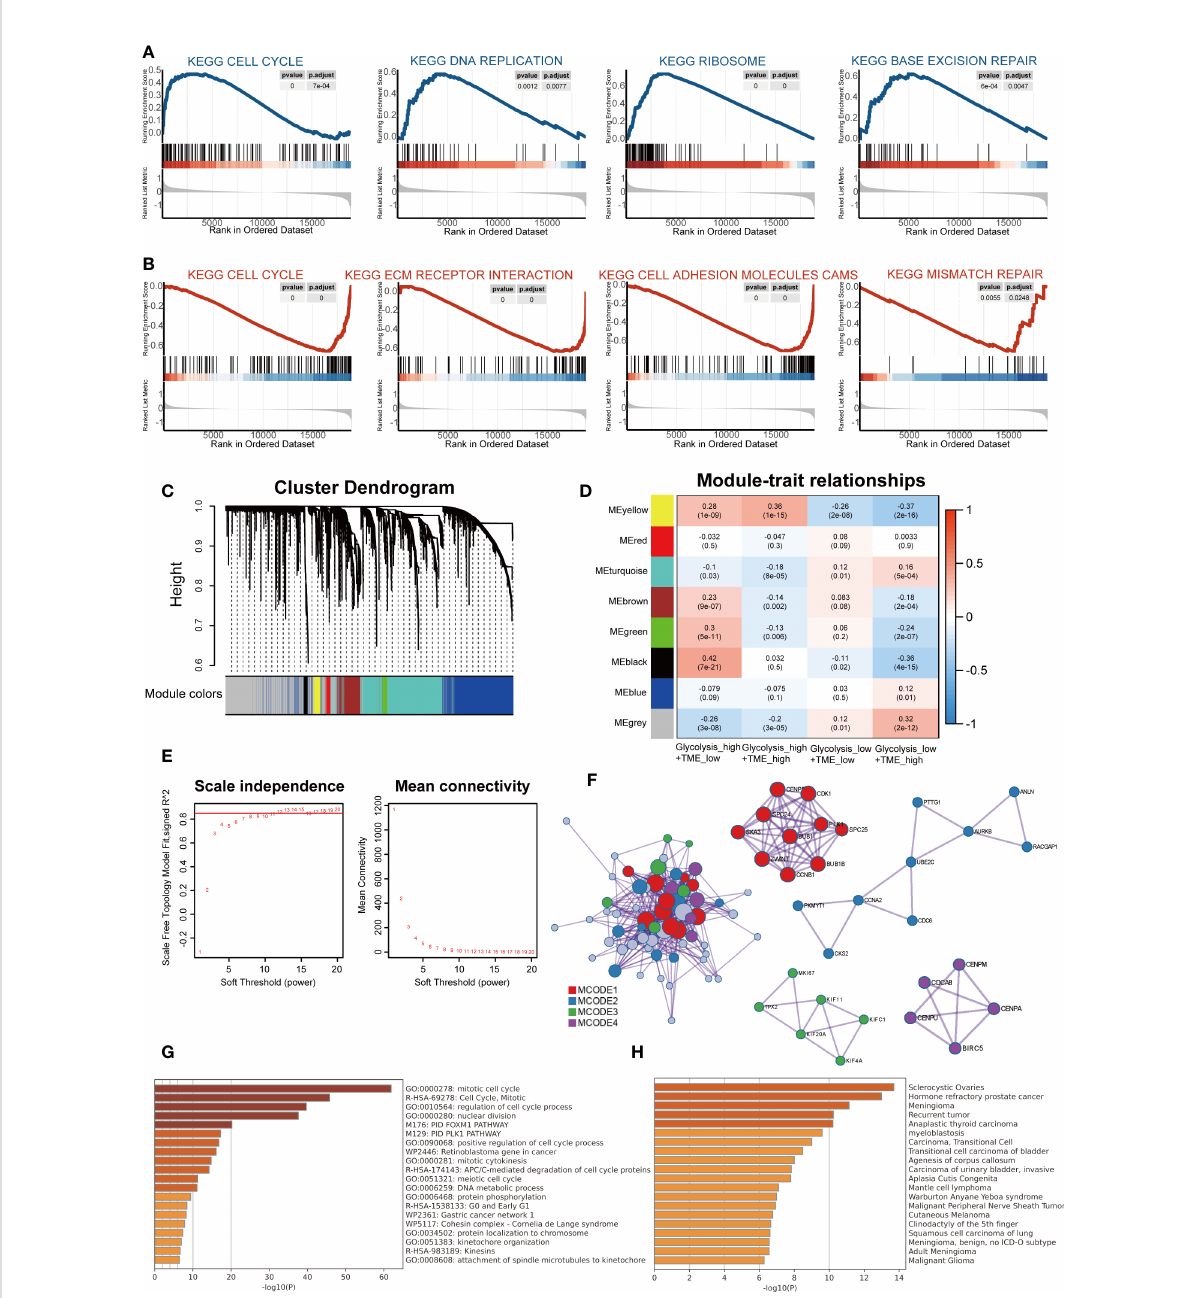
FIGURE 4 The distinct molecular functions and mechanisms among different groups. (A) Gene set enrichment analysis (GSEA) between groups with high- and low-glycolysis scores. (B) GSEA between groups with high- and low-TME scores. (C) Cluster Dendrogram. (D) Module-trait relationships. (E) Analysis of the network topology for various soft-thresholding powers. (F) Protein-protein interaction (PPI) network and four MCODEs identi fi ed in genes of the black module. (G) Potentially enriched terms for the gene list. (H) Bar graph of enriched diseases in